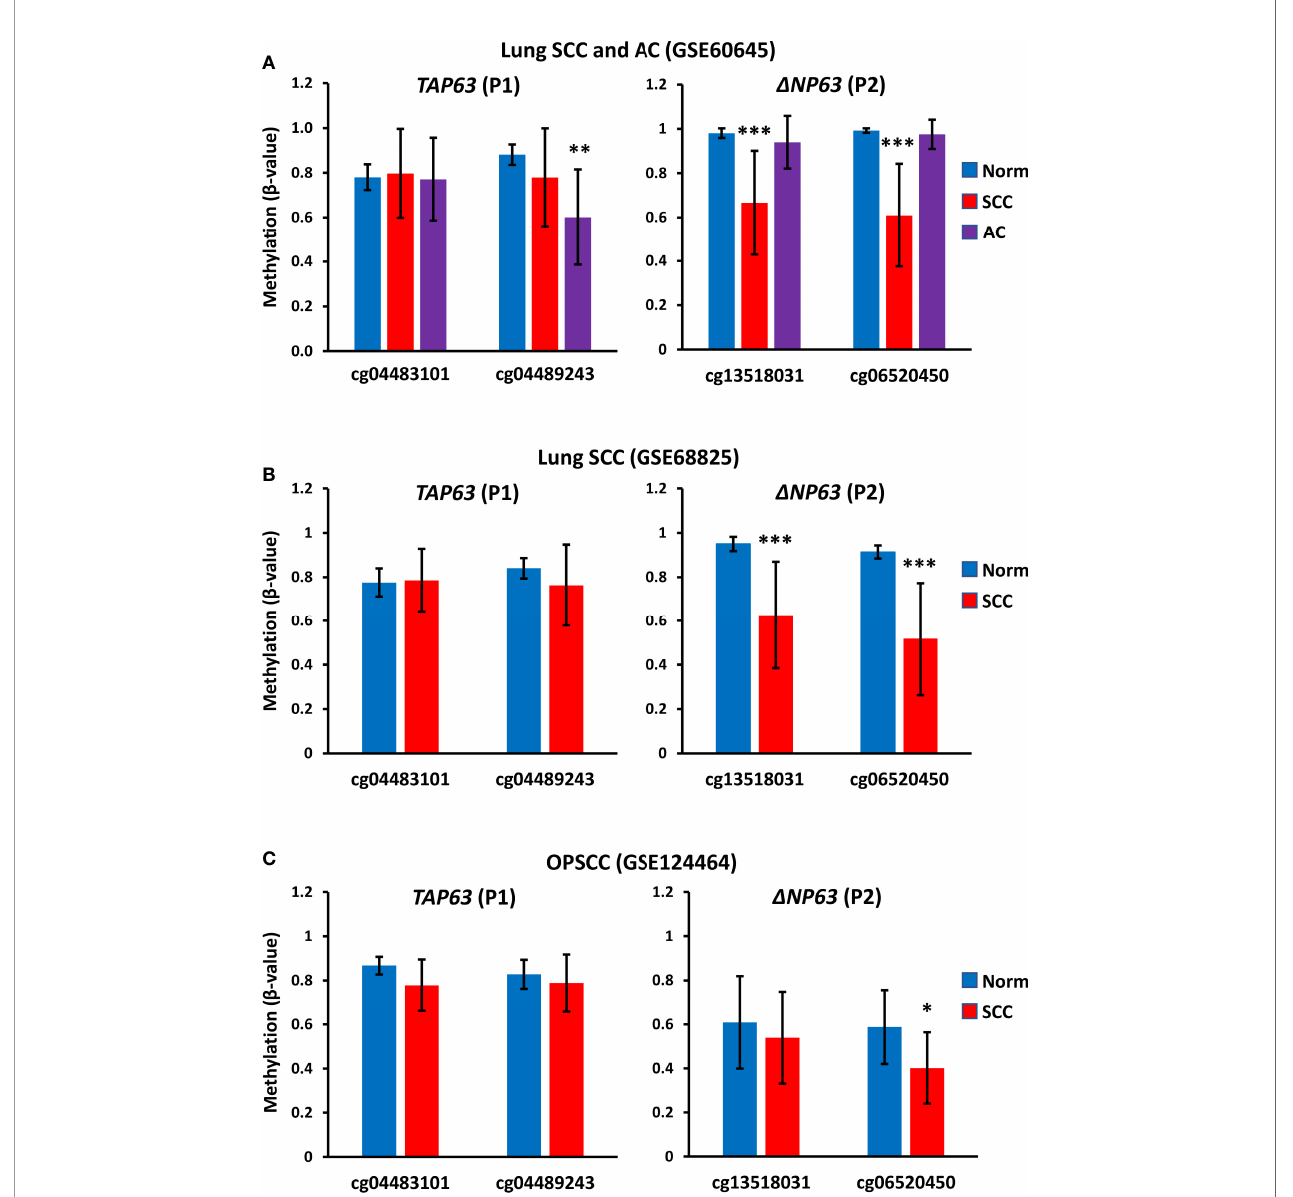
FIGURE 9 | TAP63 promoter methylation levels in primary SCC tumor samples . Graphs show data for two probes (cg04483101 and cg04489243) that lie immediately upstream of the TAP63 promoter (P1) (see Figure 6) and for two probes closest to the D NP63 promoter (P2) identi fi ed in (25). (A) Data from GSE60645 containing normal lung (Norm; n=12), lung SCC (n=22) and lung adenocarcinoma (AC, n= 81). (B) Data from the cancer genome atlas analysis of lung SCC (GSE68825; normal lung (n=43) and lung SCC (n=96). (C) Data from GSE124464 of oropharyngeal SCC (OPSCC) (n=64) and normal oral mucosa (n=5). Graphs represent mean b -values ± SD. b -values range from 0 (no methylation) to 1 (complete methylation). *p < 0.05, ***p < 0.001, Mann-Whitney